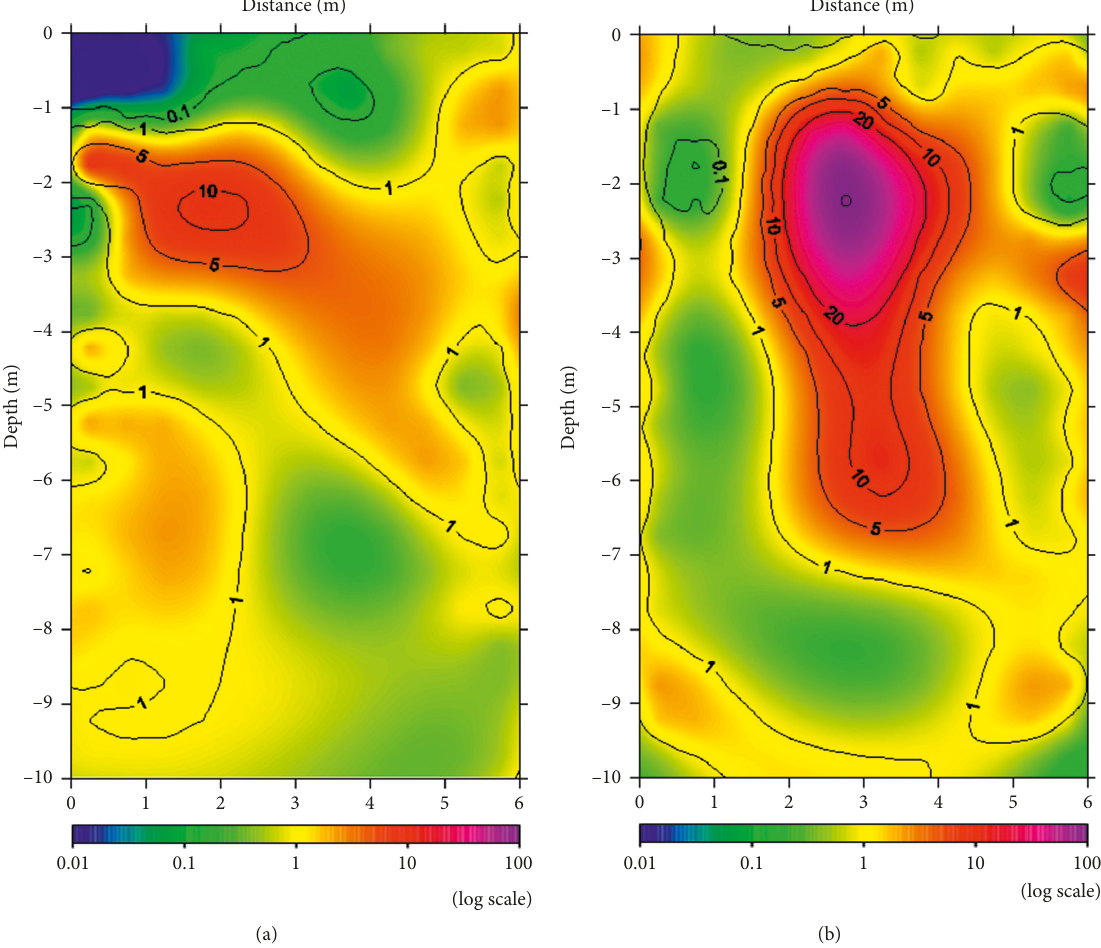
Figure 13: Electrical resistivity ratio contours of 4th test over 1st test (a) and (b) 4th test over 2nd